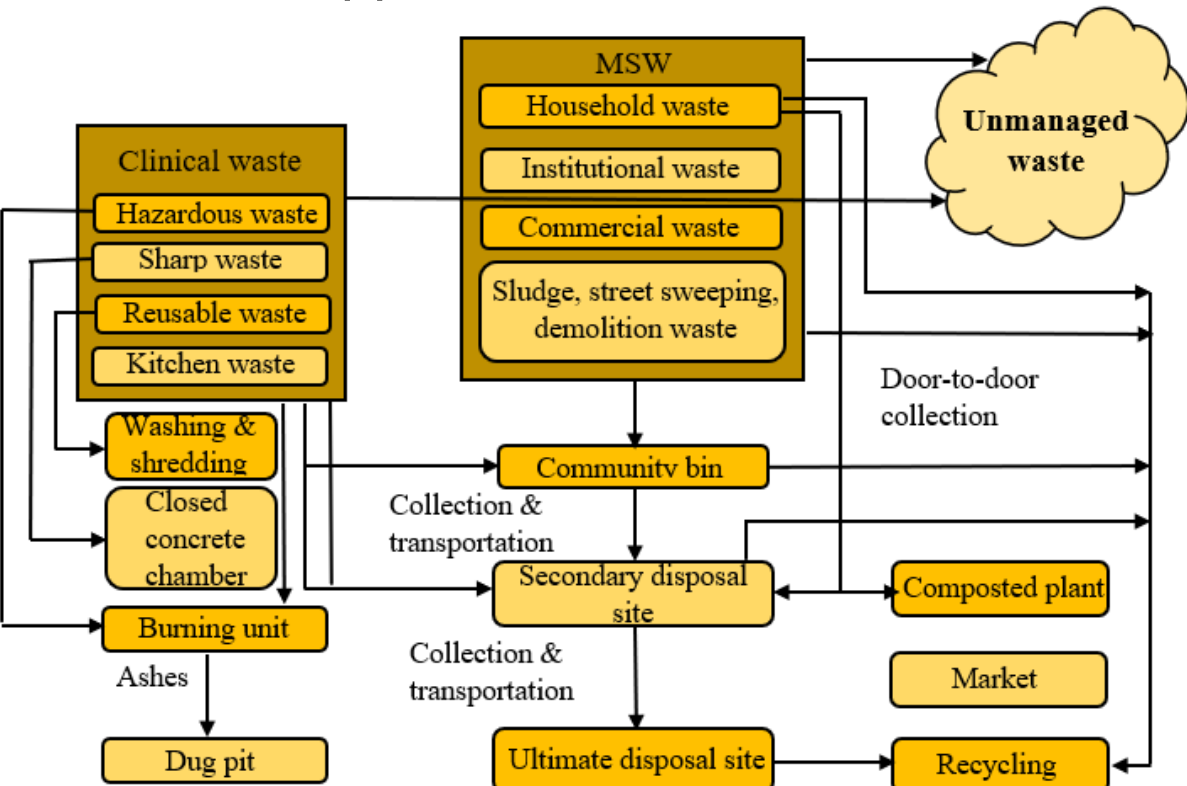
Figure 2. Schematic flow diagram of MSW management by composting.